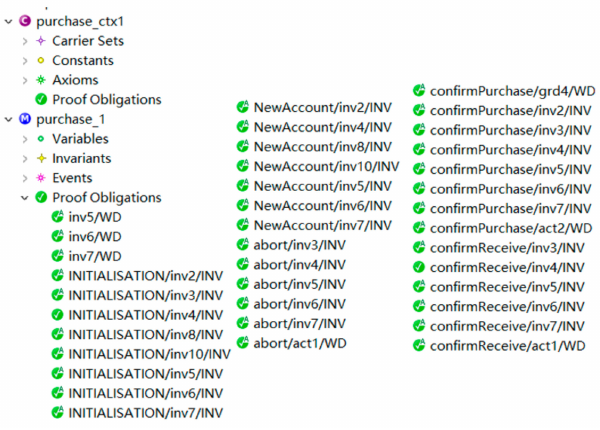
Figure 9. Verified proof obligations of the Event-B model.